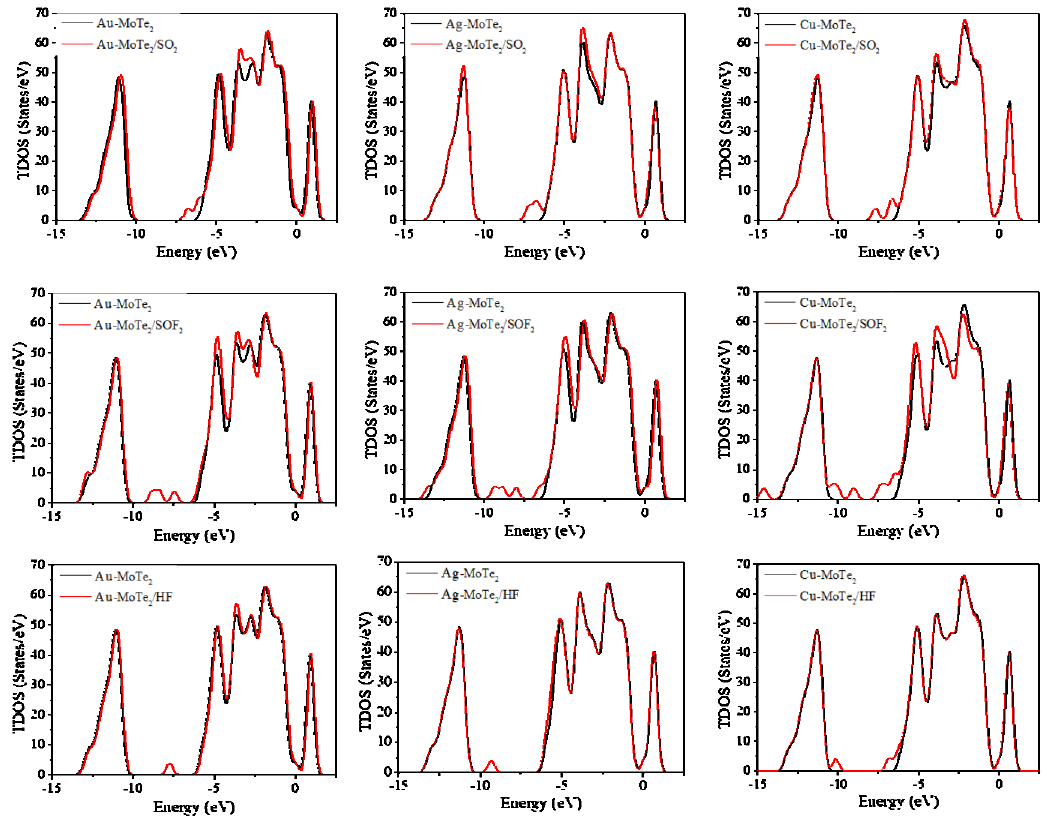
Figure 5. TDOS distribution of SO 2 , SOF 2 , and HF adsorbed TM-MoTe 2